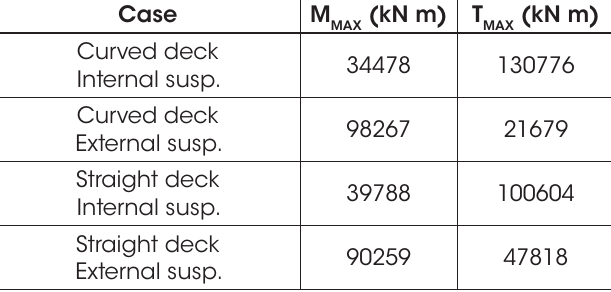
Comparison of results: pylon with reduced